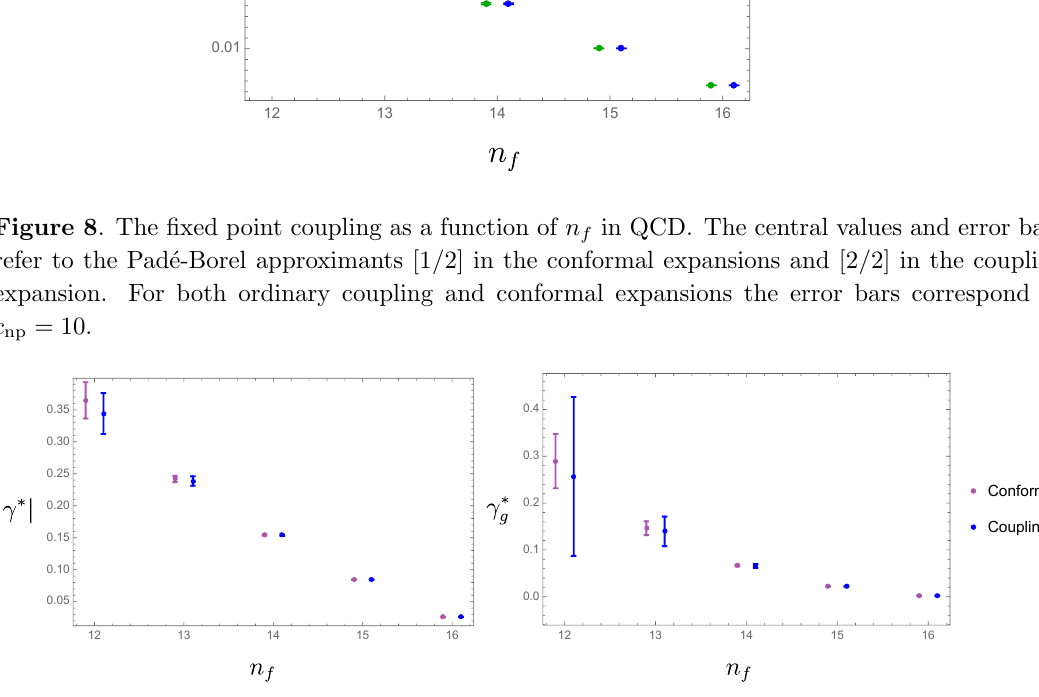
Figure 9 . Values of j (cid:13) (cid:3) j (left) and (cid:13) (cid:3) (right) as a function of n f in QCD. The central values g and error bars refer to the Pad(cid:19)e-Borel approximants [0 = 3] in the conformal expansions and [2 = 2] in the coupling expansion for both j (cid:13) (cid:3) j and (cid:13) (cid:3) . In both panels and for both ordinary coupling and g conformal expansions the error bars correspond to c np =